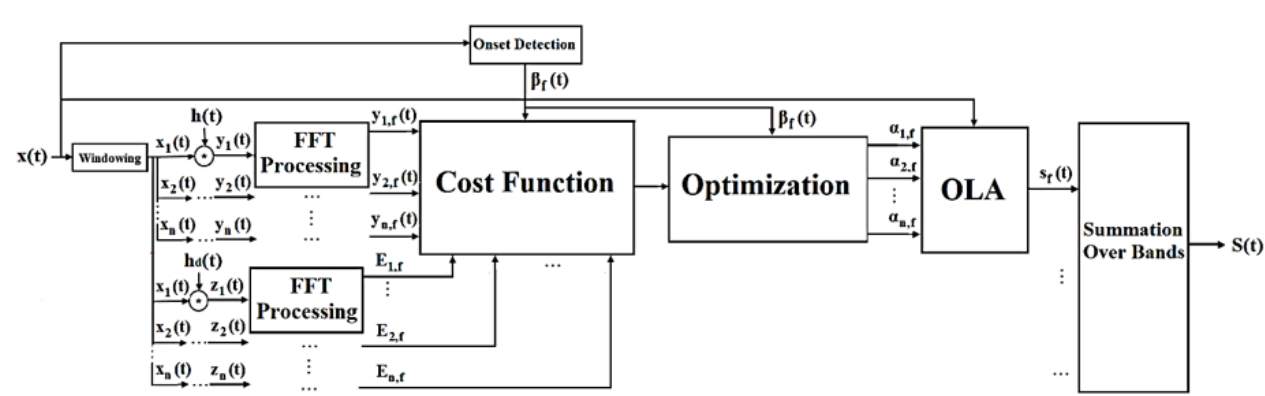
Figure 1. Block diagram of the proposed NELE approach. The preprocessing includes signal windowing, convolving short frames with the RIR to construct extended frames, FFT processing and bin separation to divide a speech into one-third octave bands and onset detection. In the cost function block, the extended frames and data of the onset detection unit are used to construct a cost function for each short frame. The constructed cost functions are iteratively optimized using the data of onset detection unit to compute the gains of short frames. Finally, the enhanced signal is reconstructed using the obtained weights by OLA and summation over one-third octave bands.